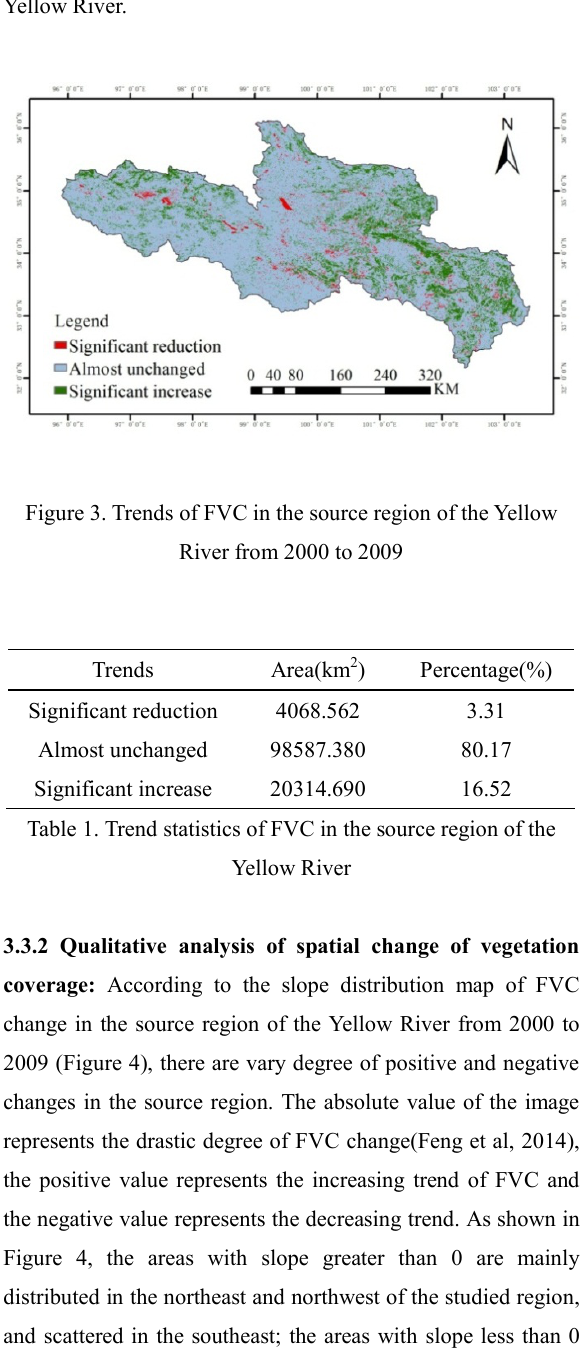
form of minimal patches or spots; on the whole, the vegetation increasing